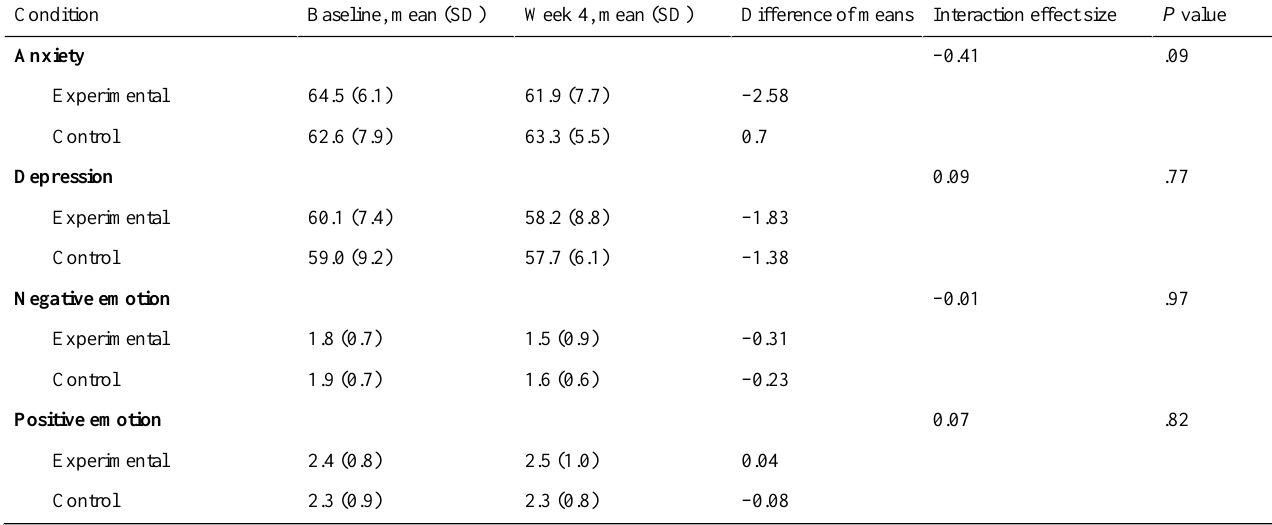
Table 2. Results for well-being outcomes (anxiety, depression, positive emotion, and negative emotion) across conditions and for experimental by control